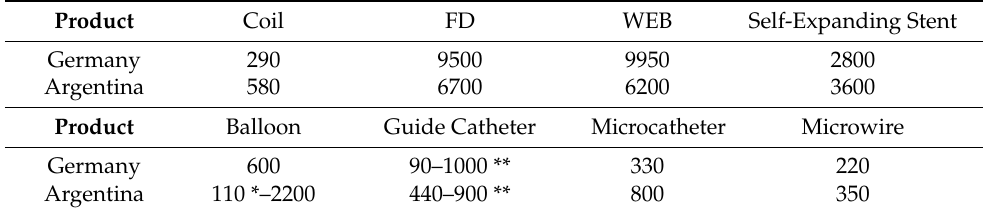
Table 2. Average price (or price range; in € ) of medical devices used for the endovascular treatment of intracranial aneurysms in Germany and Argentina in 2020. Costs are based on information from various industry sources; balloon, remodelling balloon catheter; FD, flow diverter; WEB, Woven